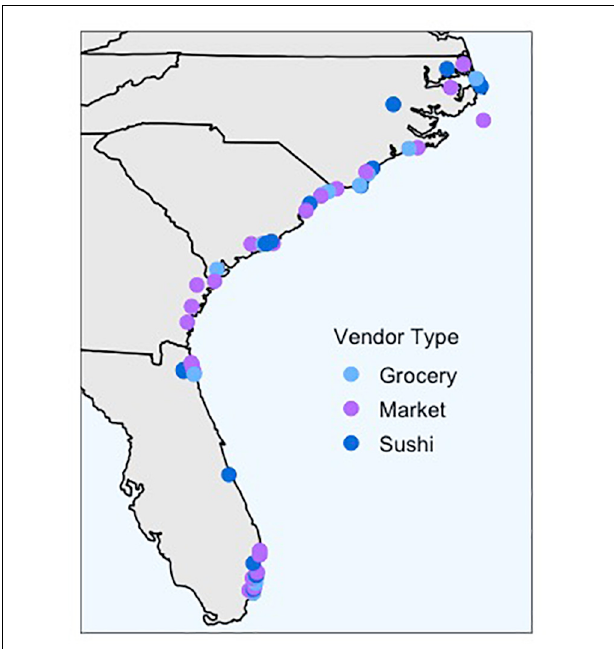
FIGURE 1 | A map of the sample sites by vendor